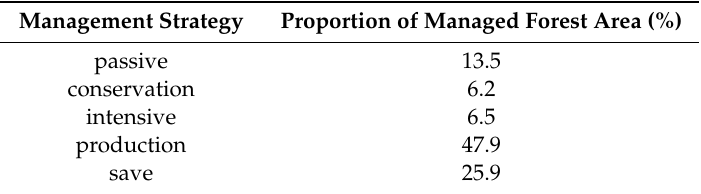
Table A4. Area proportions of the five management strategies applied for the production